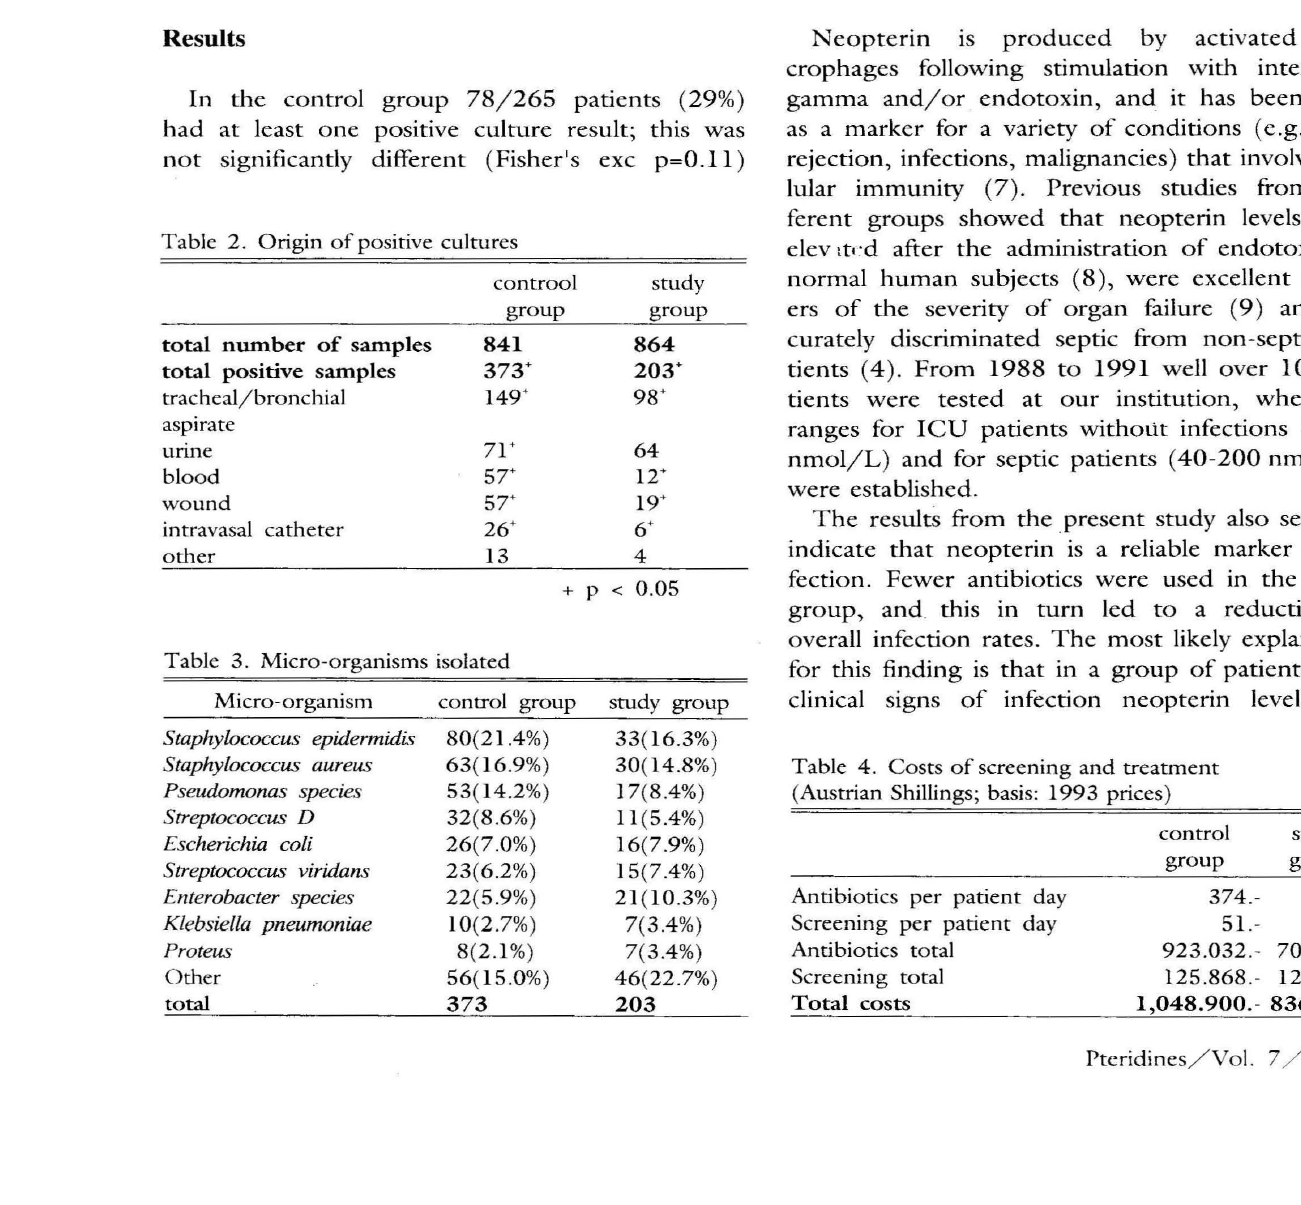
Table 4. Costs of screening and